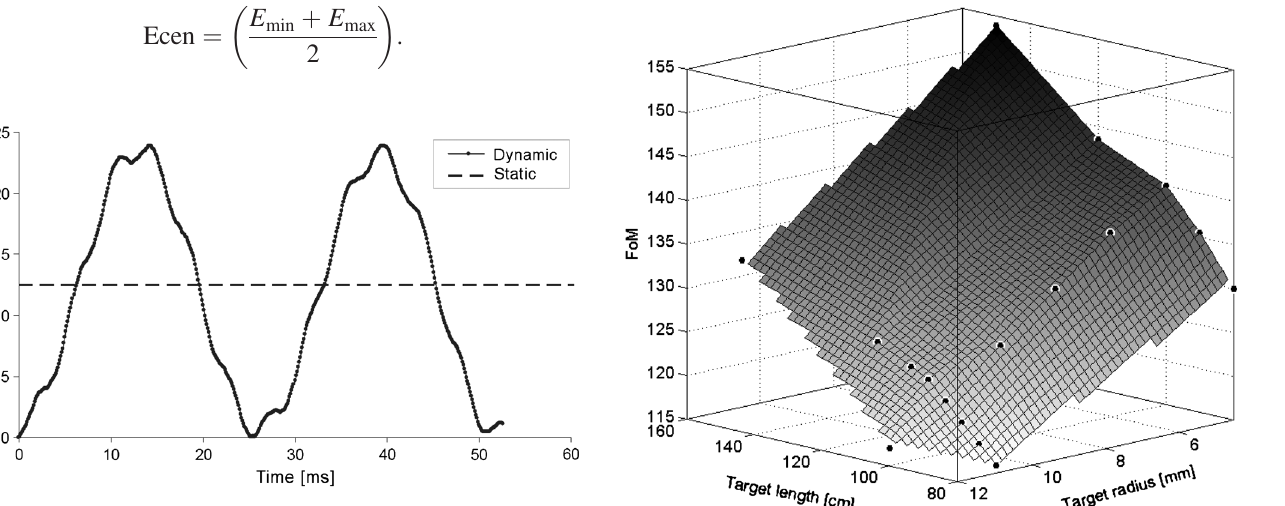
FIG. 7. FOM as a function of target radius and length with target radius ¼ 3 σ